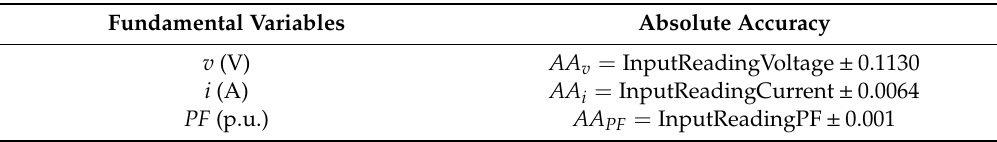
Table 16. Fundamental variables and absolute accuracy.